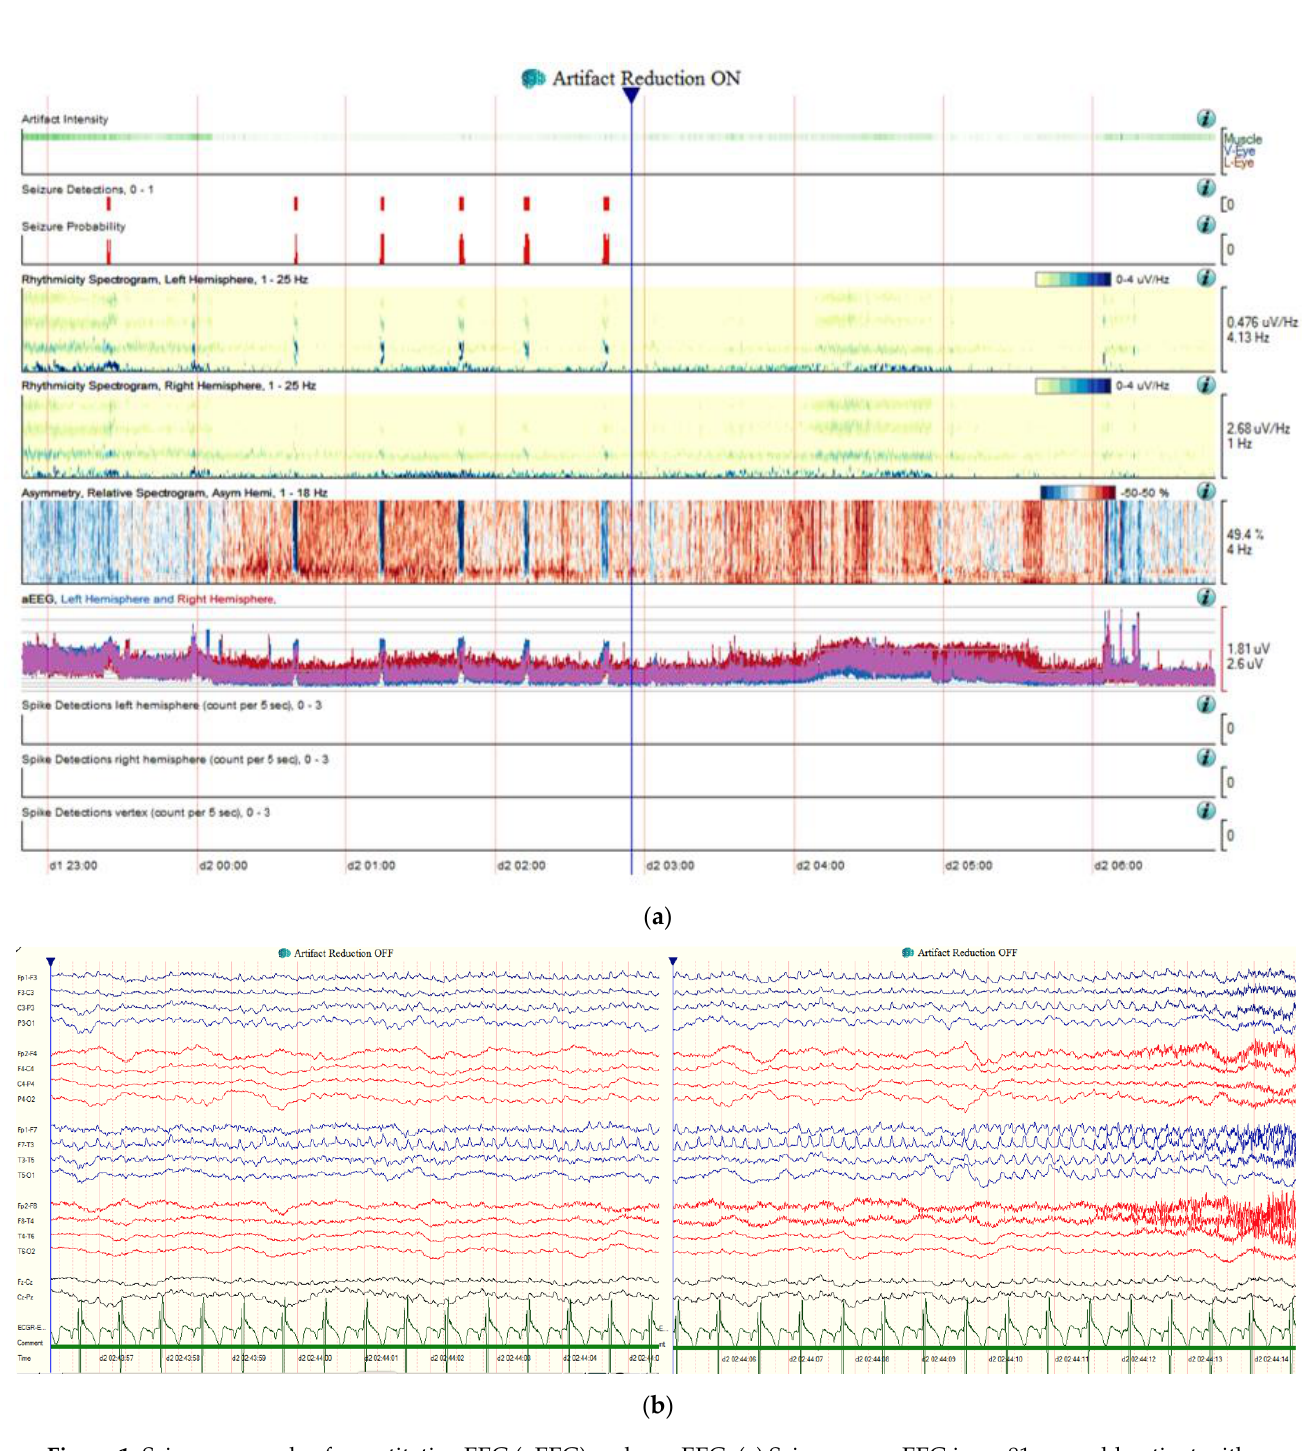
Figure 1. Seizure example of quantitative EEG (qEEG) and raw EEG. ( a ) Seizures on qEEG in an 81-year-old patient with history of epilepsy who presented with SE in the settings of bacteremia. The seizure detection and seizure probability are shown in an 8-h window of EEG monitoring; indicating 6 seizures. Additionally, increased rhythmicity is more pronounced on the left hemisphere compared to the right hemisphere, clear asymmetry (relative spectrogram) and increased amplitude on the left hemisphere (blue color) on an EEG during the seizures. qEEG can be used as a tool to assist clinicians with the diagnosis and the evaluation of treatment response in patients with SE. ( b ) One of the seizure events is demonstrated on the raw EEG, with left hemispheric distribution.